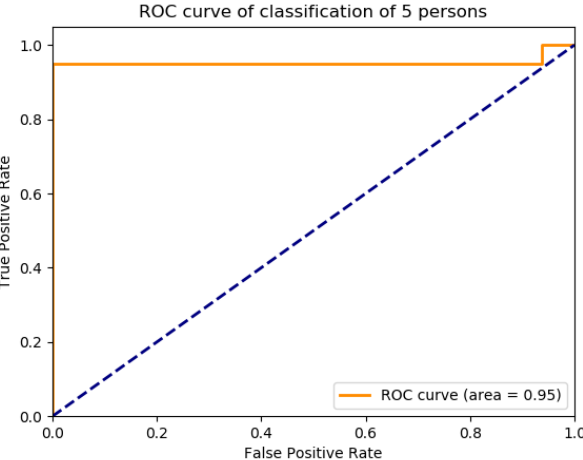
Figure 15. Confusion matrix of the proposed model for the twenty-five persons.